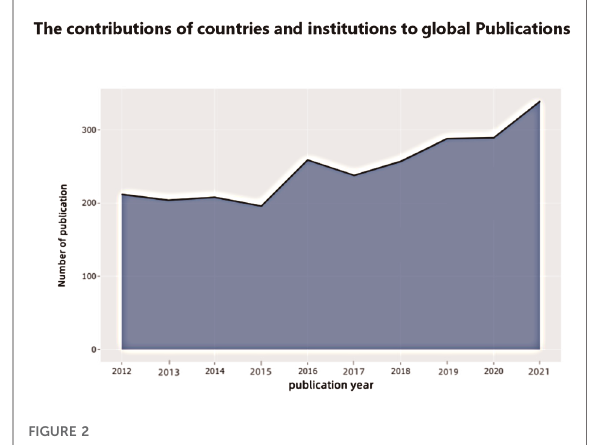
FIGURE 2 The annual number of publications worldwide.